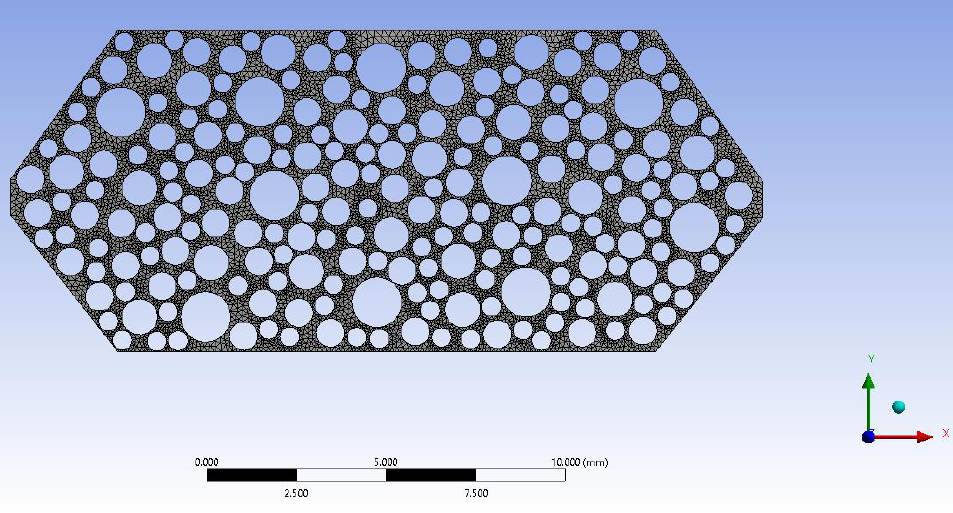
Figure 3. Mesh generated for this study.